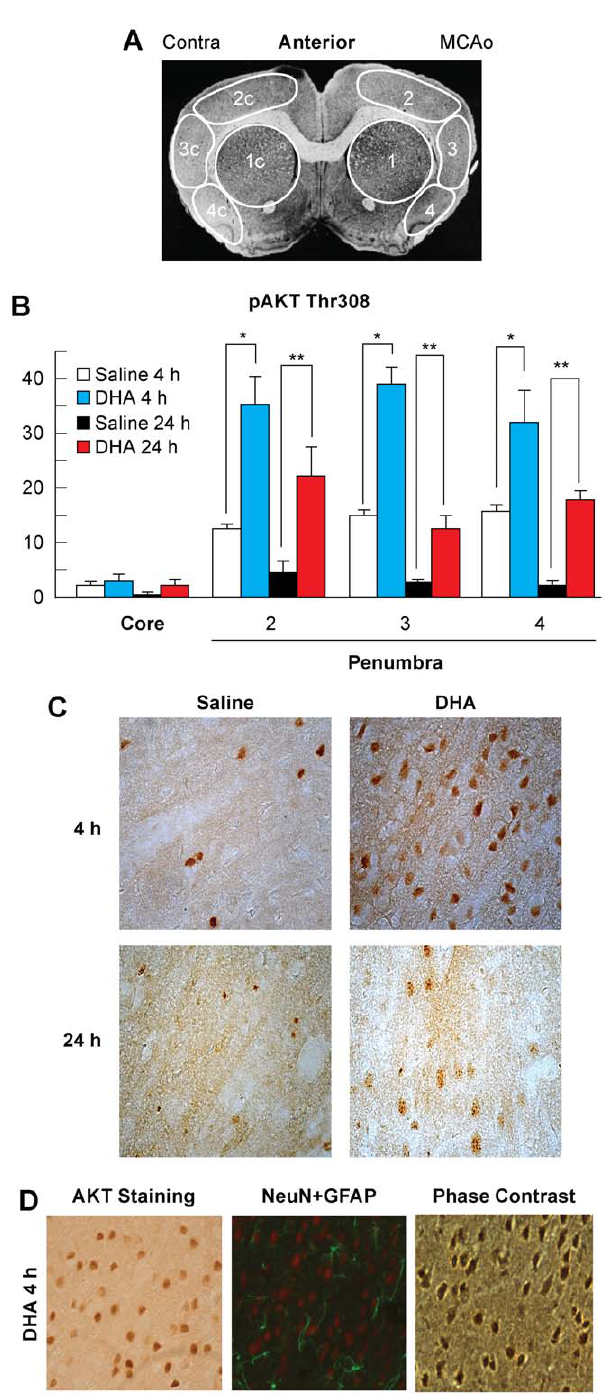
Figure 3. AKT p308 immunohistochemistry in young rats. Panel A:Schematic coronal brain diagram showing locations of regions for cell counts in core (1) and penumbra (2, 3 and 4). Panel B: Number of p308 AKT-positive cells at 4 and 24 h after MCAo. Panel C: Bright field images of p308 AKT-positive cells at 4 h and 24 h after 2 h of MCAo at a magnification 6 40. Panel D: Evidence that p308 AKT stains neurons. Bright field image of AKT staining, computer-generated MosaiX- processed images of GFAP (green)/NeuN (red) double staining (overlay) and phase contrast image of DHA treated rat at 4 h after 2 h of MCAo at a magnification 6 40 Data are mean 6 SEM. * and ** indicate significant difference between groups (p , 0.05; repeated measures ANOVA followed by Bonferroni